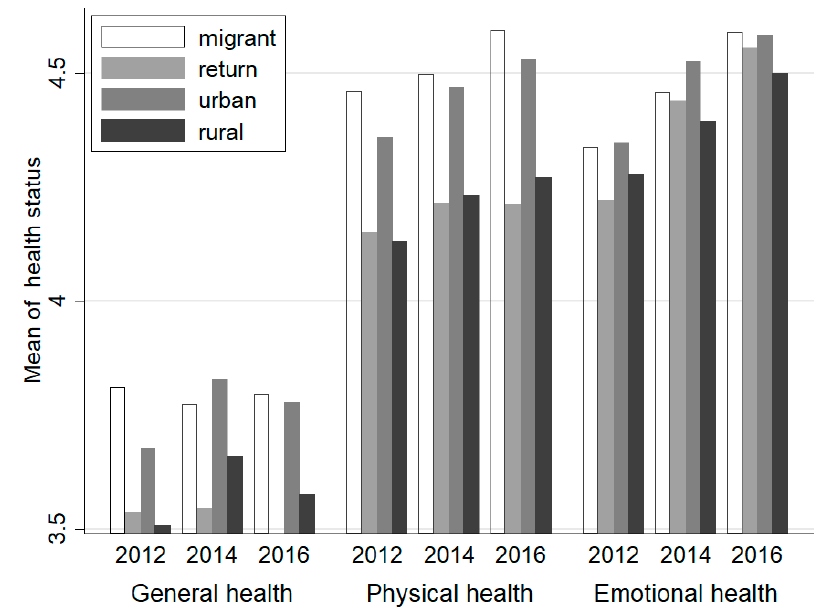
Figure 1. Health differences of four types of population in 2012–2016 (wave 1–3). Note: Health outcomes all transform into the five-point Likert Scale, with excellent health coded as 5 and poor health coded as 1.